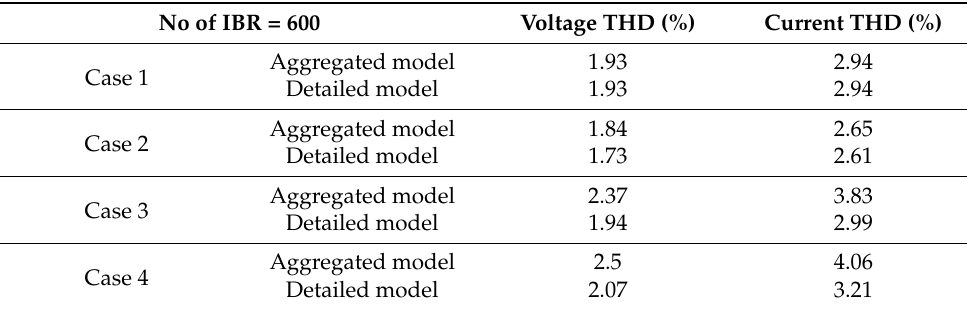
Figure 11. Active and reactive power at the POM for Case 1 using aggregated and detailed models: ( a ) Active power, ( b ) Reactive Power.